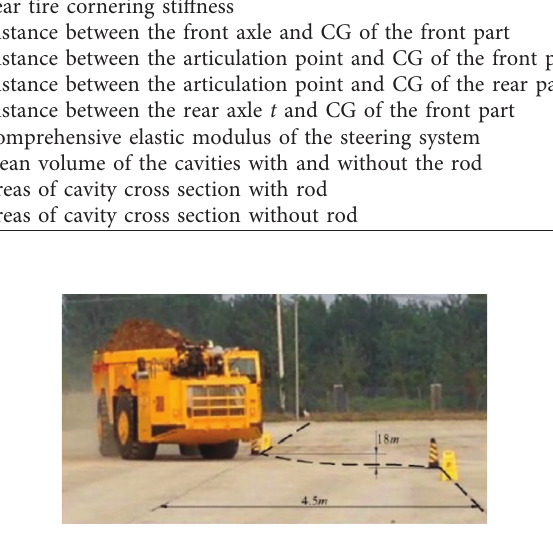
Figure 2: Field test scenario.